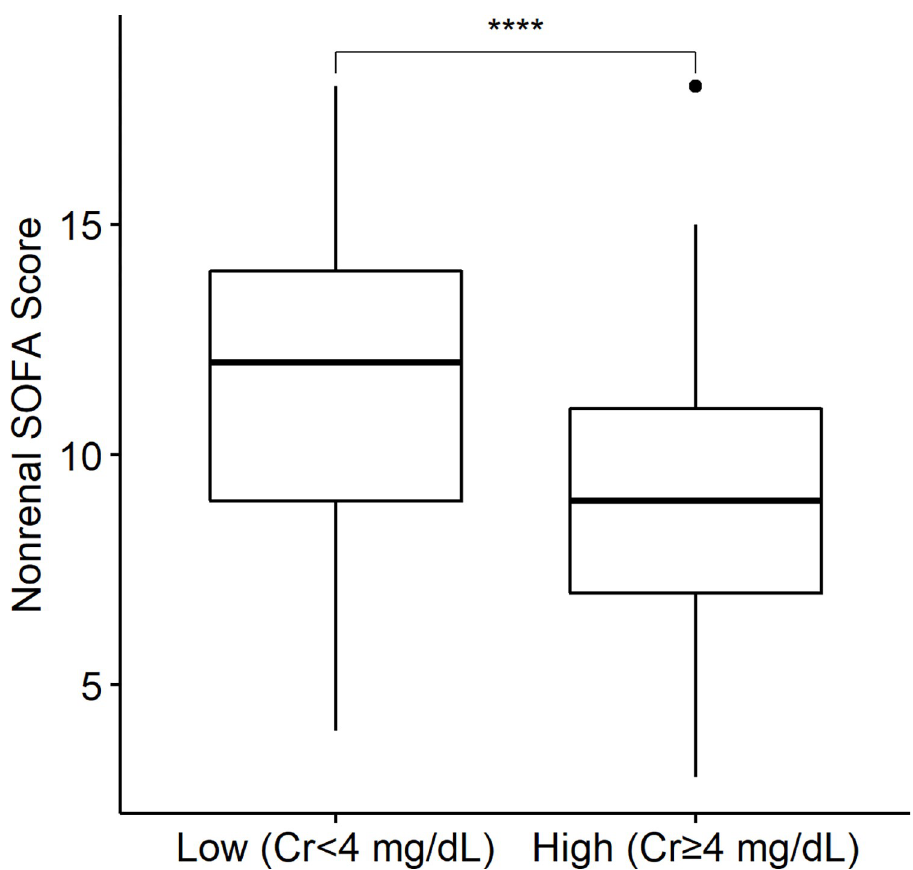
Fig 5. Box plot of nonrenal SOFA score between the low-creatinine (Cr < 4 mg/dL) group and the high-creatinine (Cr � 4 mg/dL) group in fluid-overloaded patients. The low-creatinine (Cr < 4 mg/dL) group had a higher nonrenal SOFA score ( Kruskal –Wallis test, P <